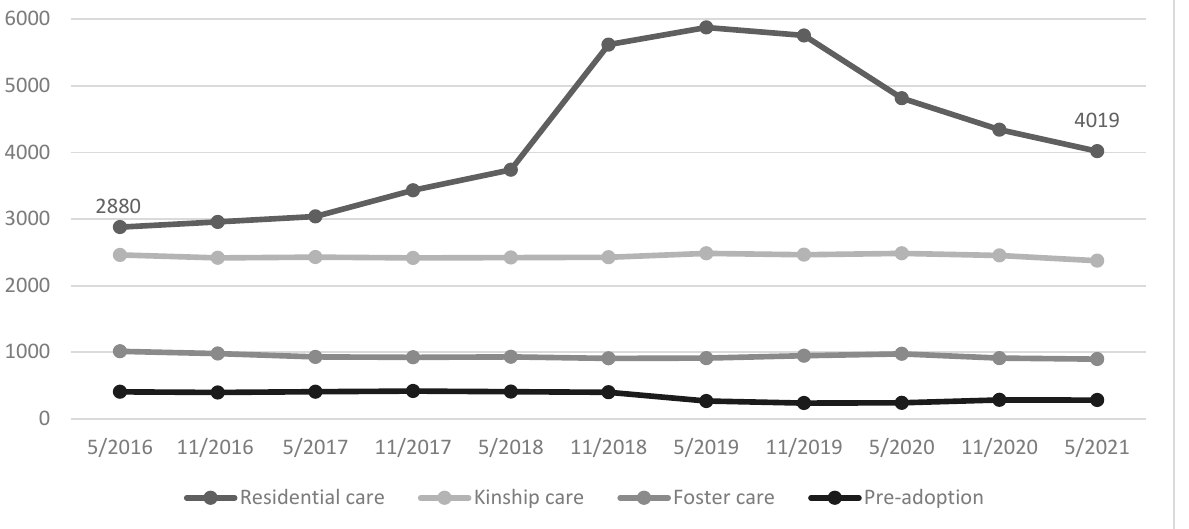
Figure 1. Evolution of care measures in Catalonia (2016–2021). Source: authors’ own work, based on official data from the DGAIA (Catalan Directorate General of Child and Adolescent Care), available at https://treballiaferssocials.gencat.cat/ (accessed on 1 November 2022).